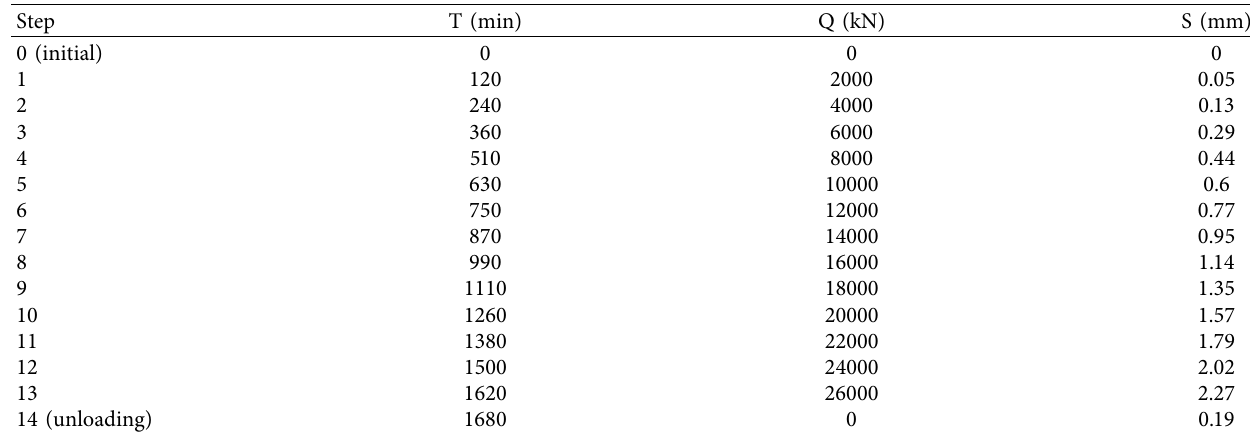
Table 2: Test results of